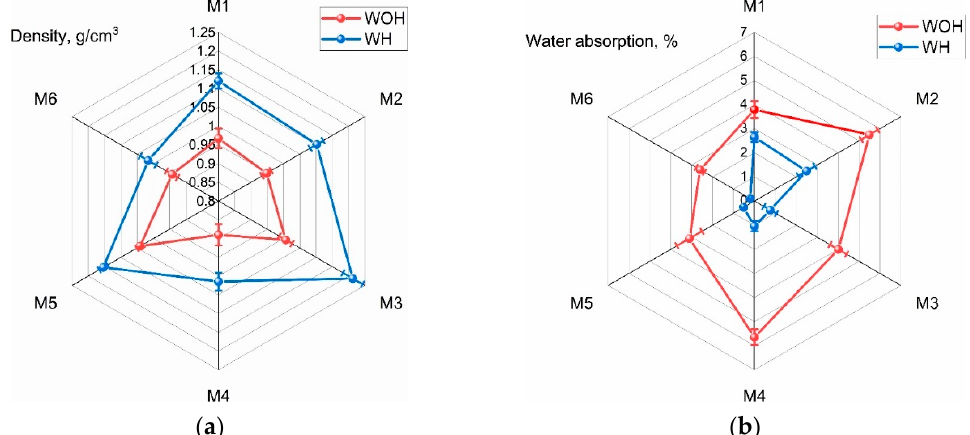
Figure 5. Density ( a ) and the water absorption ( b ) of ASR − based blends test results in distilled water at 25 °C.